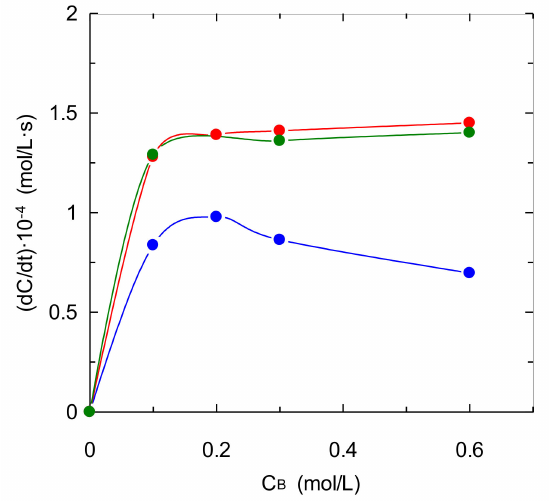
Figure 5. Effect of type of center of amino centers upon absorption rate. C B = 0.6 mol·L —1 . Q G = 0.2 L·min —1 . TMEDA; DMEDA [13]; EDA.